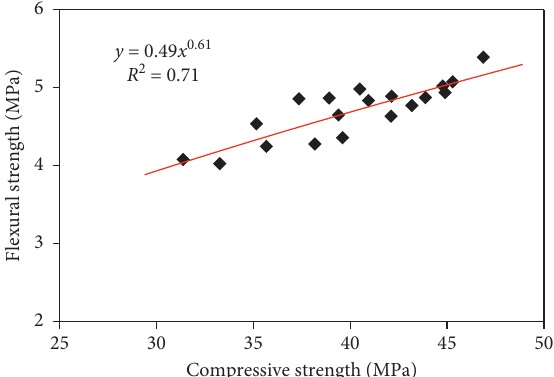
Figure 17: Correlation between flexural strength and compressive strength of the mixes with